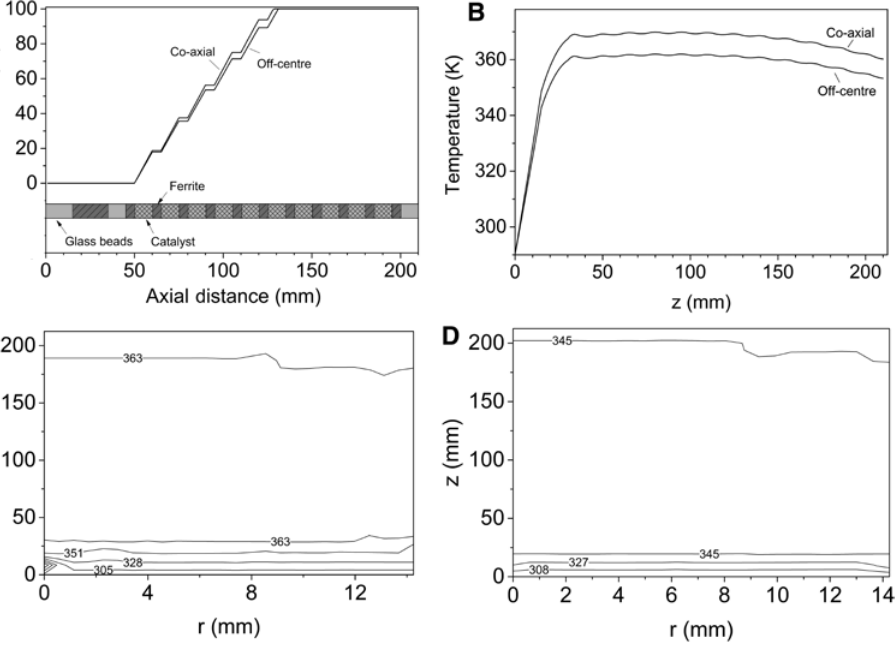
Figure 5: (A) 2-Methyl-3-butyne-2-ol (MBY) conversion and (B) center axis temperature in the 11 zone R-15 reactors as a function of axial position, (C, D) temperature maps of R-15 reactor positioned (C) in the center of the coil (D) near the edge (see Figure 7). Reaction conditions are the same as those in Figure